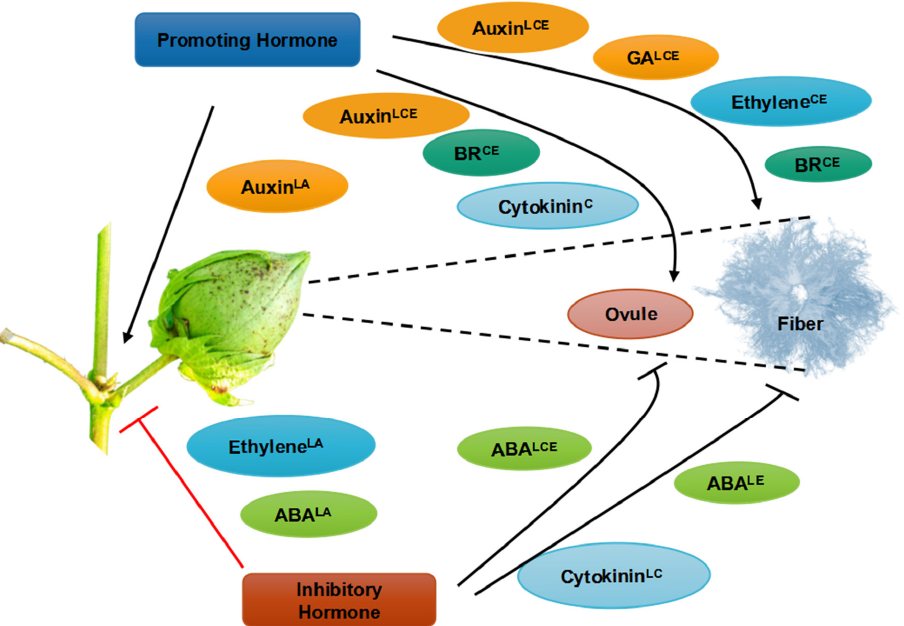
Figure 3. Hormones affecting fiber development, ovule growth, and boll retention. A schematic depiction of a cotton plant’s secondary stem, fruiting stem, and boll (left) and an enlarged view of a fiber-bearing ovule (right) are shown. Hormones that promote boll maintenance, ovule growth, and fiber initiation or growth (left to right) are shown at the top with arrows; inhibitory hormones are shown at the bottom with blocked blunted lines.